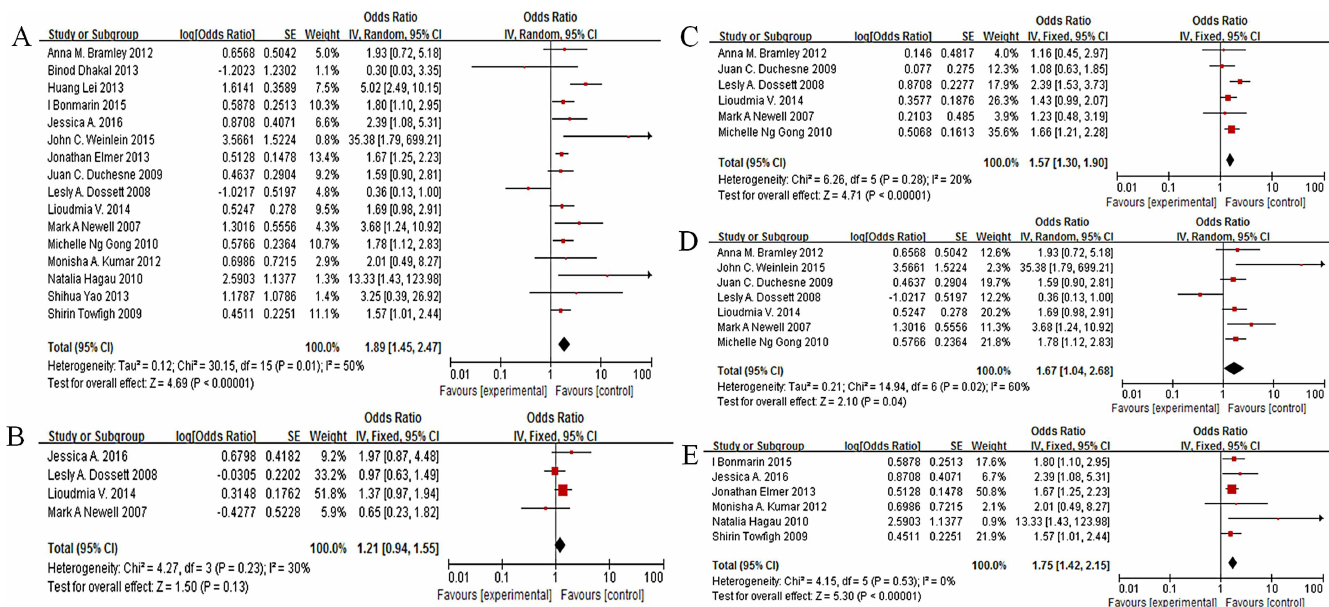
Fig 2. Association of obesity and morbidity in ARDS/ALI patients. A: pooled result; B: overweight(BMI25-29.9kg/m 2 ) vs normal; C: obese(BMI30- 39.9kg/m 2 ) vs normal; D: morbid obese(BMI (cid:21) 40kg/m 2 ) vs normal; E:obese(BMI (cid:21) 30kg/m 2 ) vs normal.